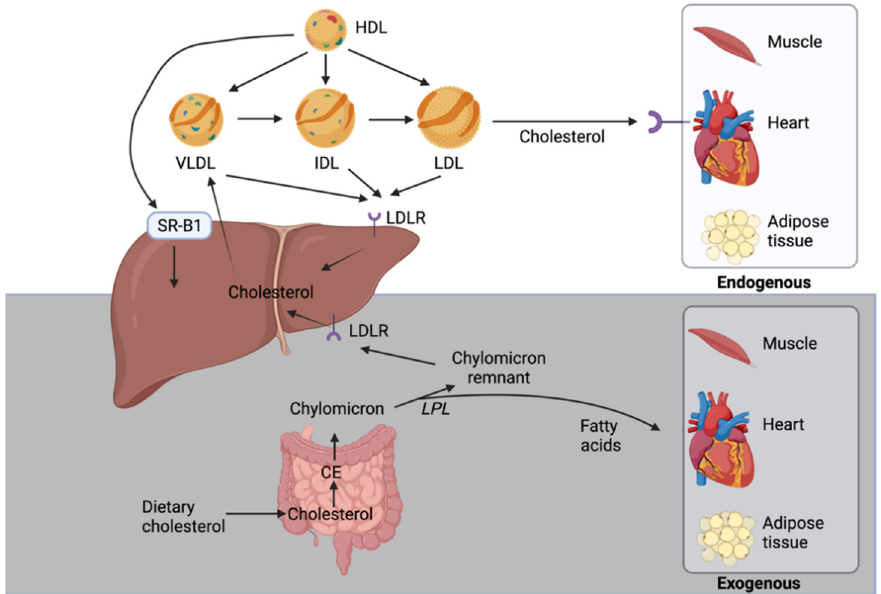
Figure 2. The endogenous (white) and exogenous (gray) pathways of cholesterol transport. The exogenous pathway starts with the dietary cholesterol whereas the liver is the starting point of the endogenous pathway.